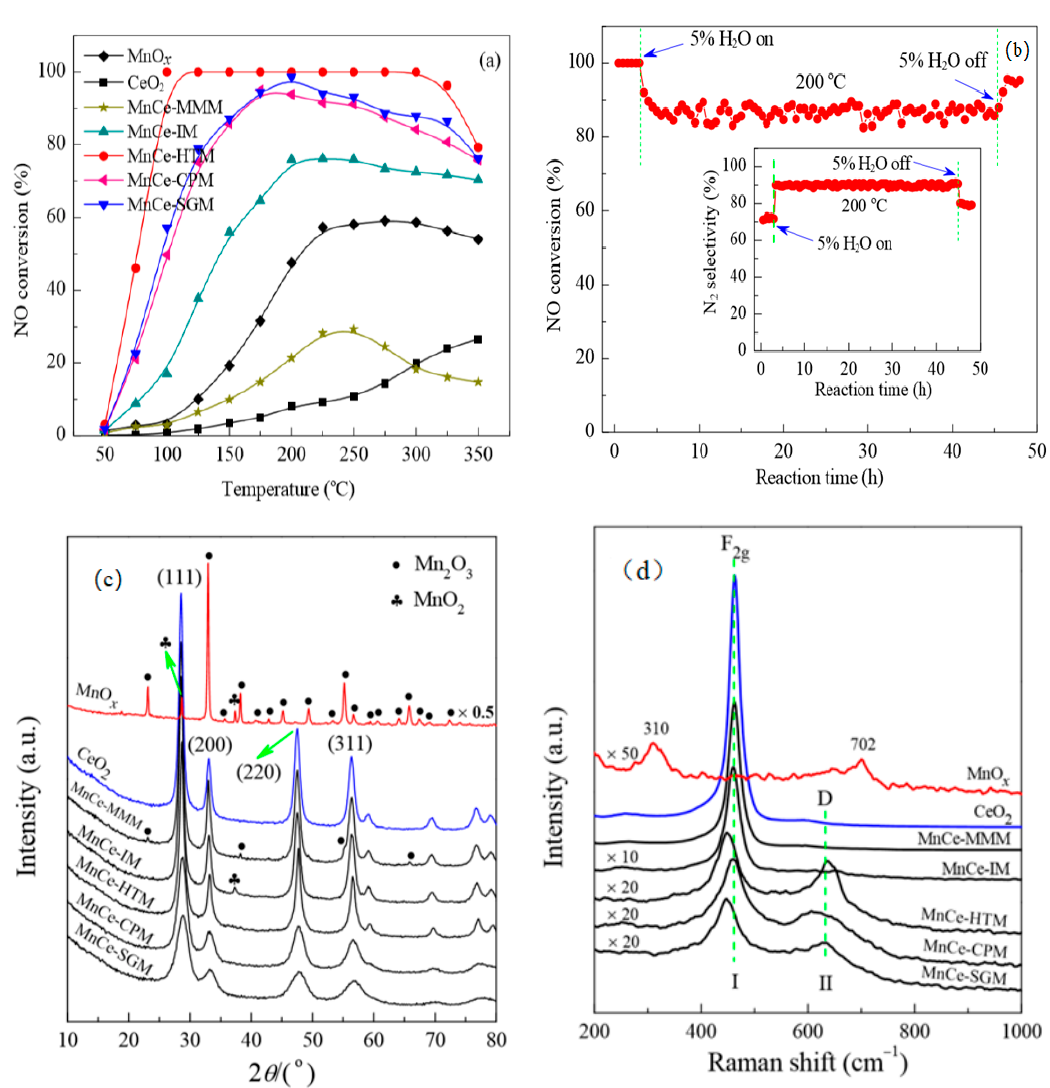
Figure 7. ( a ) NO conversion of the synthesized MnO x –CeO 2 catalysts; ( b ) the H 2 O resistance of MnCe-HTM catalyst at 200 °C; ( c ) XRD patterns and of the synthesized catalysts and; ( d ) Raman spectra of the synthesized catalysts [57].